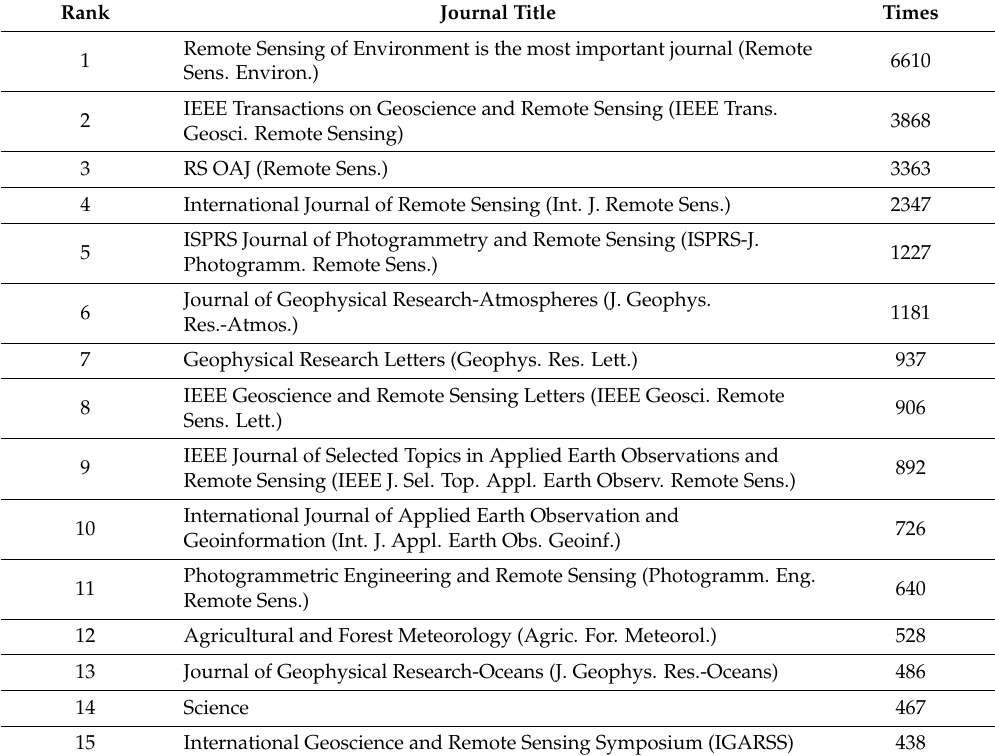
Table 13. The articles of the Journals that cite RS OAJ frequently (Top